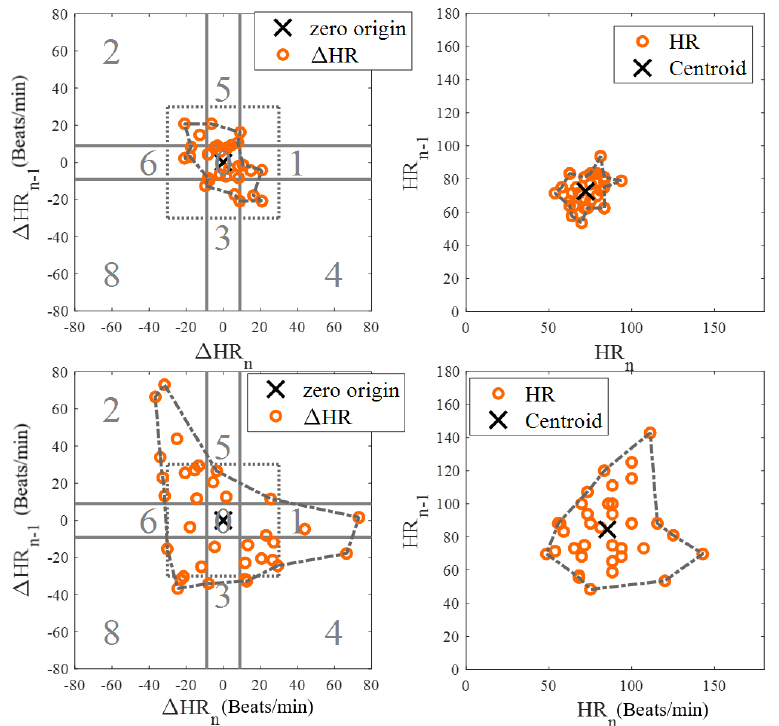
Figure 4. Poincaré plots for basal ( top panels ) and RVR ( bottom panels ) heart rate AF detection. The left panels are the Poincaré plot of heart rate difference, and the right panels are the Poincaré plot of heart rate. In the left panels, the entire Poincaré plot is separated into 9 regions, which are also used to locate erroneous peaks for peak correction during PAC/PVC detection.